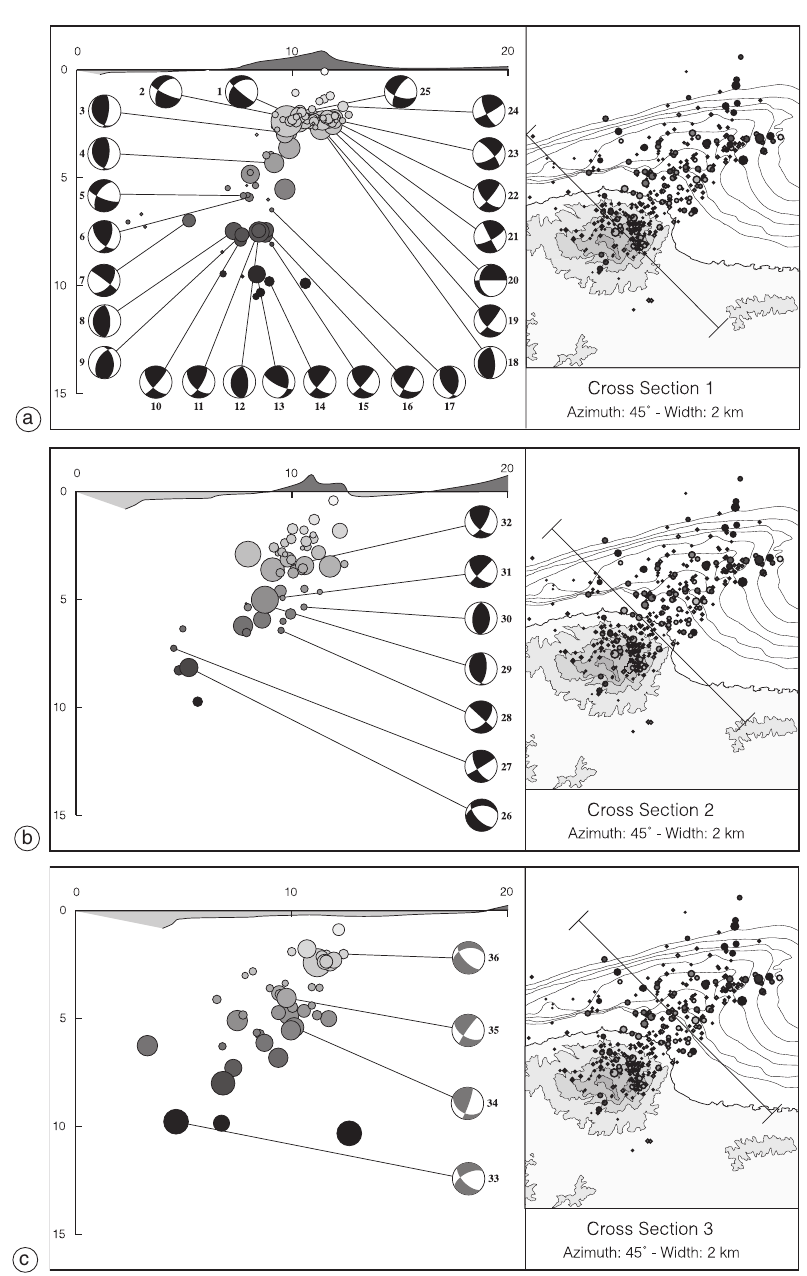
Fig. 7a-c. Vertical cross sections through the hypocenters of the aftershocks along the lines shown in the insets. No vertical exaggeration above sea-level, vertical exaggeration under sea-level by a factor 5. The focal mechanisms are shown in the lower hemisphere equal area